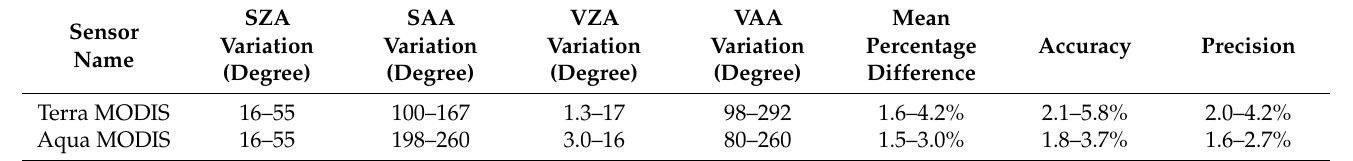
Table 13. Model specifications by analyzing the larger field of view